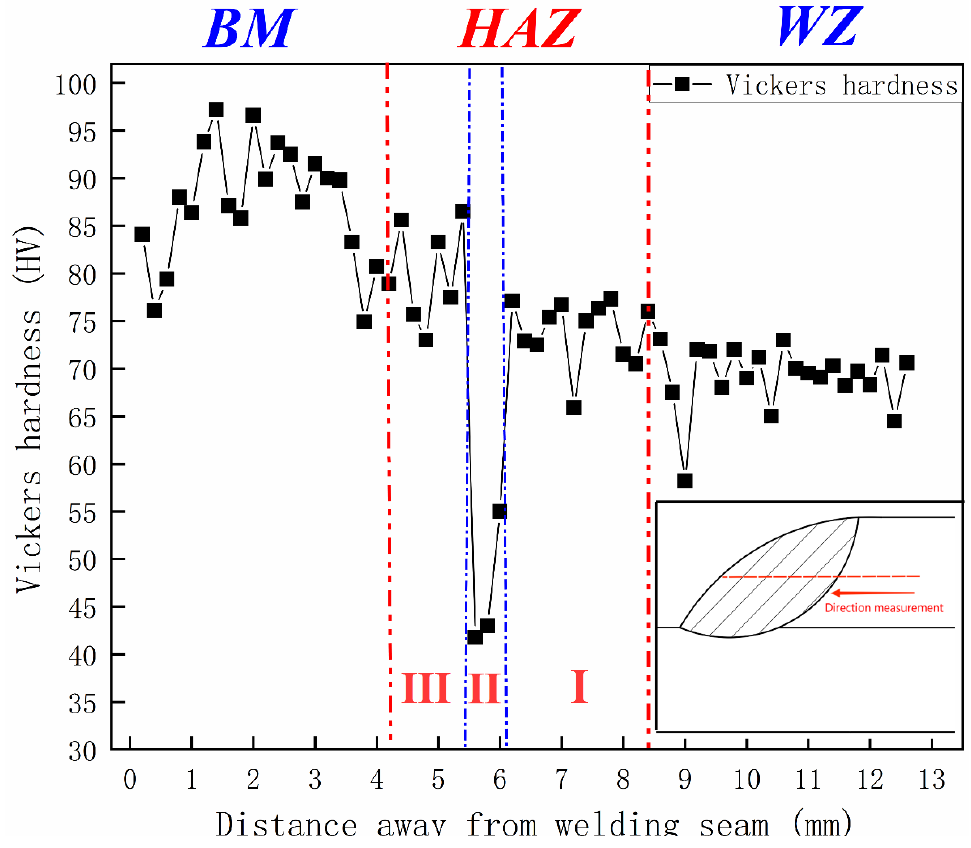
Figure 4. Weld hardness.